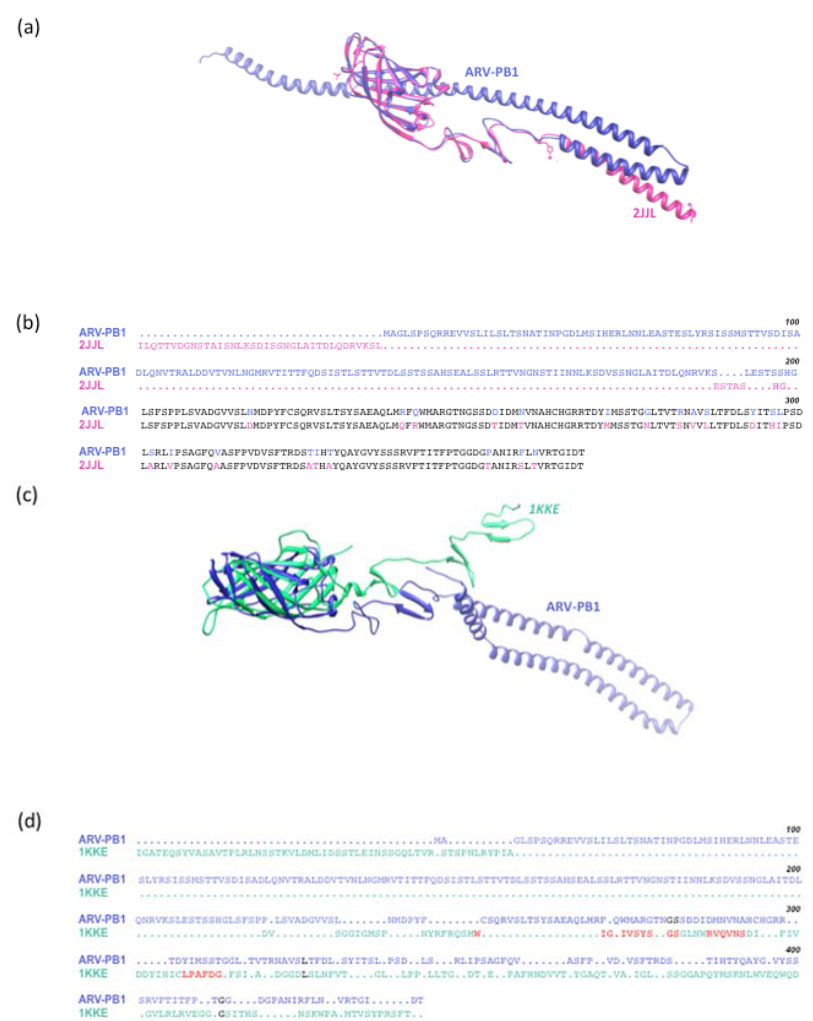
Figure 8. In silico structure generation of the S1 attachment protein of ARV-PB1. ( a ) I-TASSER-generated ARV-PB1 (blue), manually superimposed with avian reovirus σ C117-326, Protein Data Bank (PDB) ID 2JJL (pink), identified as the most closely related crystal structure. ( b ) Tertiary structural alignment of the S1 protein of ARV-PB1 and 2JJL. Conserved sequence regions are highlighted in black. ( c ) I-TASSER-generated ARV-PB1 (blue), manually superimposed with mammalian orthoreovirus 3 (Dearing strain), PDB ID 1KKE (green), using 1KKE as a generation template. ( d ) Tertiary structural alignment of the S1 protein of ARV-PB1 and 1KKE. Conserved sequence regions are highlighted in black, and the epitope targets of neutralizing antibodies are highlighted in red.